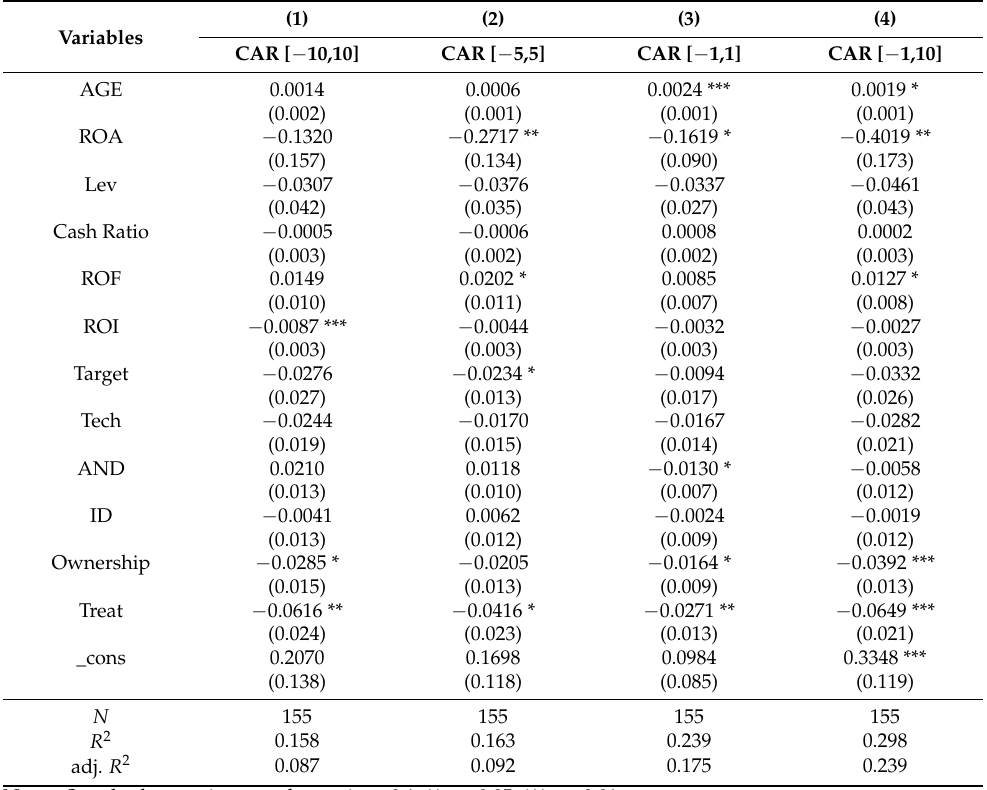
Table 8. Robustness checks on event study.